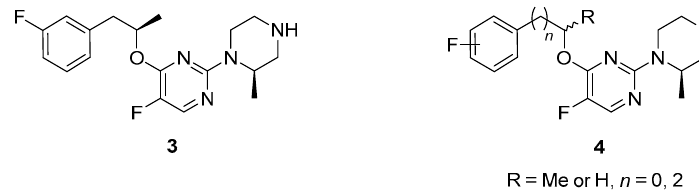
Figure 2. The structures of reported 5-HT 2C agonist 3 and designed compounds 4 .